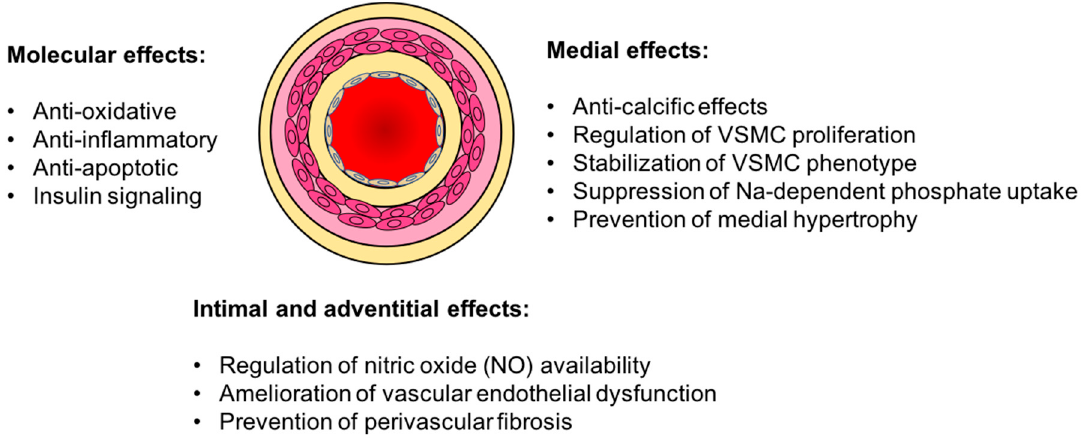
Figure 1. Vasculo-protective effects of Klotho. The presence of Klotho can exert pleiotropic protective effects against age-associated arterial changes. VSMC, Vascular Smooth Muscle Cells.